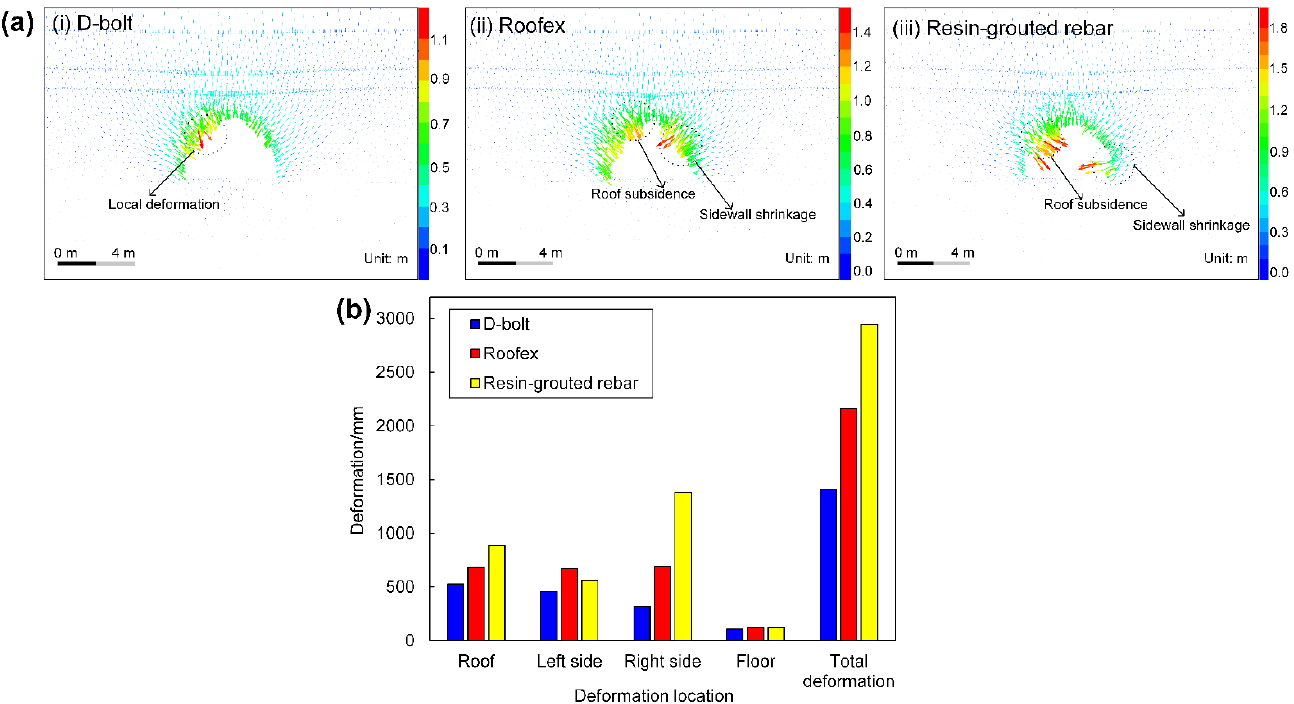
Figure 12. ( a ) Simulated displacement vectors of the surrounding rock masses along the tunnel supported by different types of rockbolts. ( b ). Comparison of the deformation of the tunnel supported by different types of rockbolts.